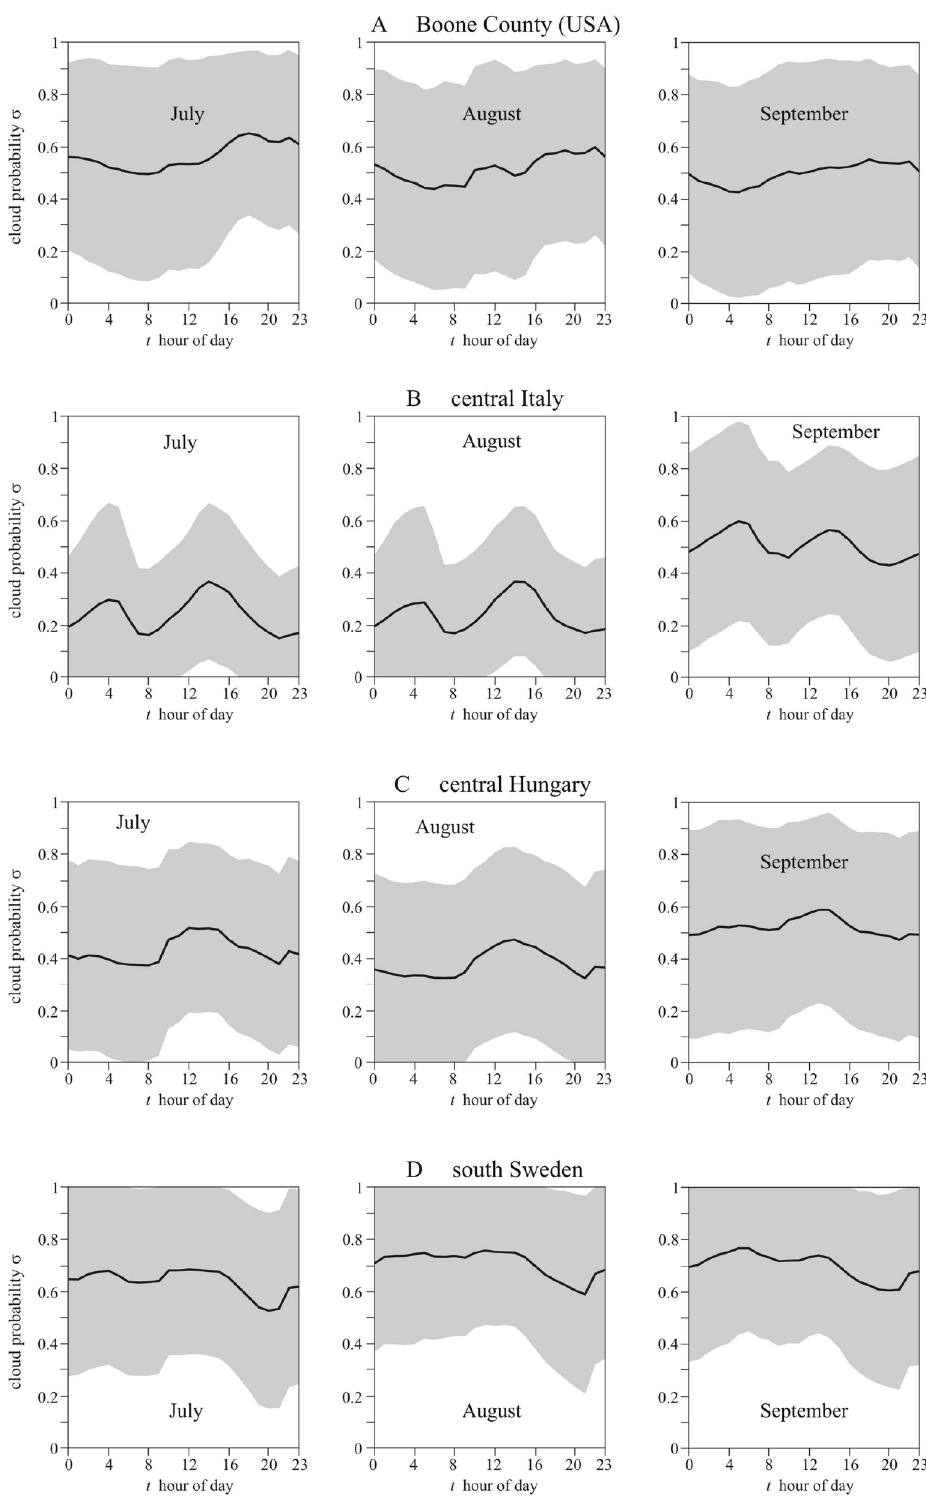
Figure 2. Cloudiness in Boone County and three European regions where sunflowers are cultivated. Diurnal mean probability σ( t ) (black solid curve) ± standard deviation (grey shading) of cloudy sky in ( A ) Boone County (Kentucky, USA, 39° N, − 84.75° E), ( B ) central Italy (41.0° N, 15.0° E), ( C ) central Hungary (47.0° N, 19.0° E), and ( D ) south Sweden (58.0° North, 13.0° East) averaged for every hour and every day in July, August, and September from ERA5 Total Cloud Cover data (period: 2009.01.01–2018.12.31, temporal resolution: 1 h, spatial resolution: 0.25° × 0.25° ≈ 27 km × 27 km). The local time t ranges from 0 to 24 h (0–1, 1–2, 2–3,…, 23–24 h) with 920 data points in every hour